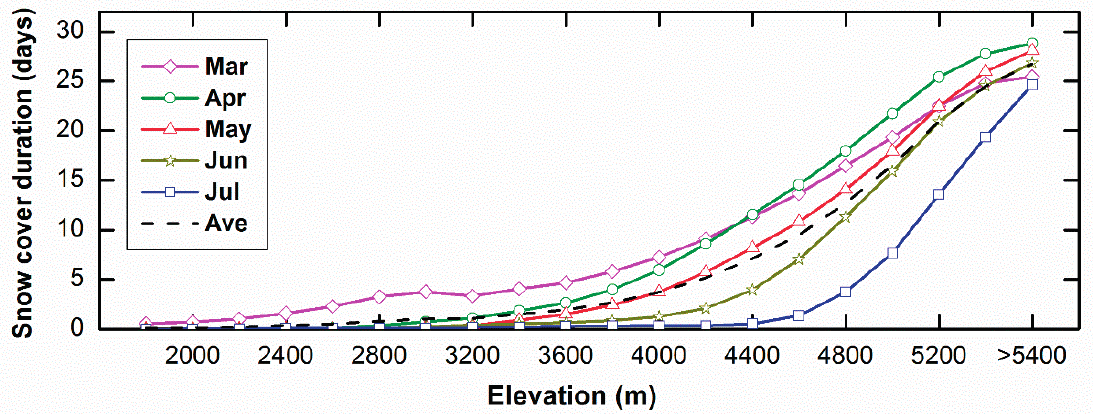
Figure 7. Mean SCDs for the months during snowmelt season (March to July) in 200 m elevation